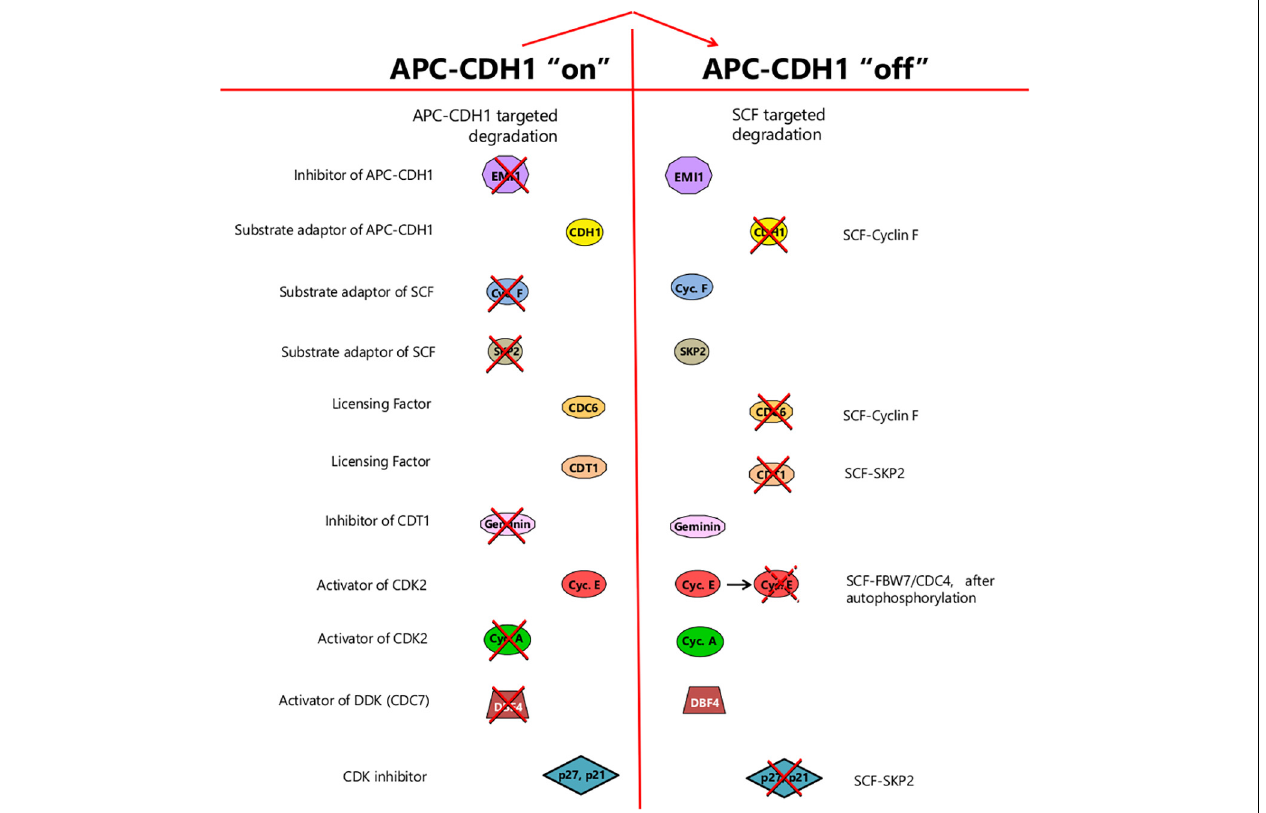
FIGURE 5 | The change of state resulting from APC/C CDH1 inactivation. Prior to this transition, the cell is in a state where proteolysis targeted by APC/C CDH1 predominates, leading to the elimination of EMI1, its own inhibitor, together with substrate adaptors for the SCF-ubiquitin ligase, and components needed for DNA synthesis such as DBF4 and cyclin A. Factors required for replication origin licensing (CDC6 and CDT1) are stable whereas geminin – an inhibitor of CDT1 and hence licensing – is destroyed. Following the switch, SCF-mediated-proteolysis is promoted by the stabilization of its substrate adaptors (such as SKP2 and cyclin F). Origin firing becomes possible on accumulation of DBF4, acting together with CDK2 activity promoted first by cyclin E, then cyclin A, with activity further enhanced by p27 and/or p21 elimination. Origin relicensing is prevented in part by SCF-targeted degradation of the CDC6 and CDT1 licensing factors together with CDT1 suppression through geminin accumulation. Thus, at the point of APC CDH1 inactivation, the cell passes from a state where origin licensing is possible but origin-firing is prevented, to one where origin-firing becomes possible but relicensing is suppressed. The change of state, once it occurs, is irreversible due to EMI1 stabilization and SCF-mediated elimination of